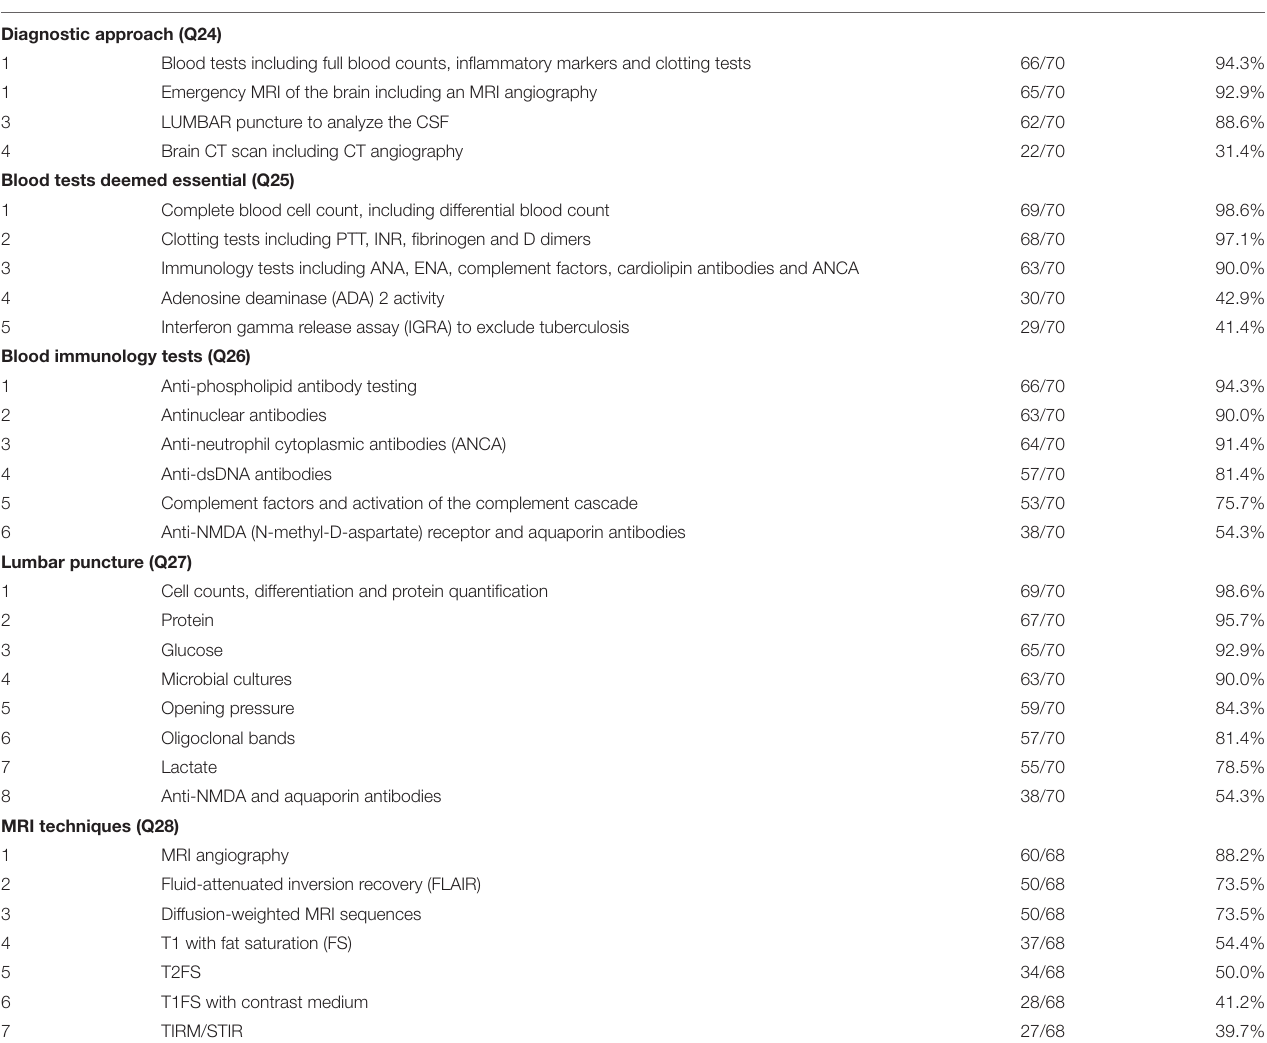
TABLE 5 | Diagnostic approach in case